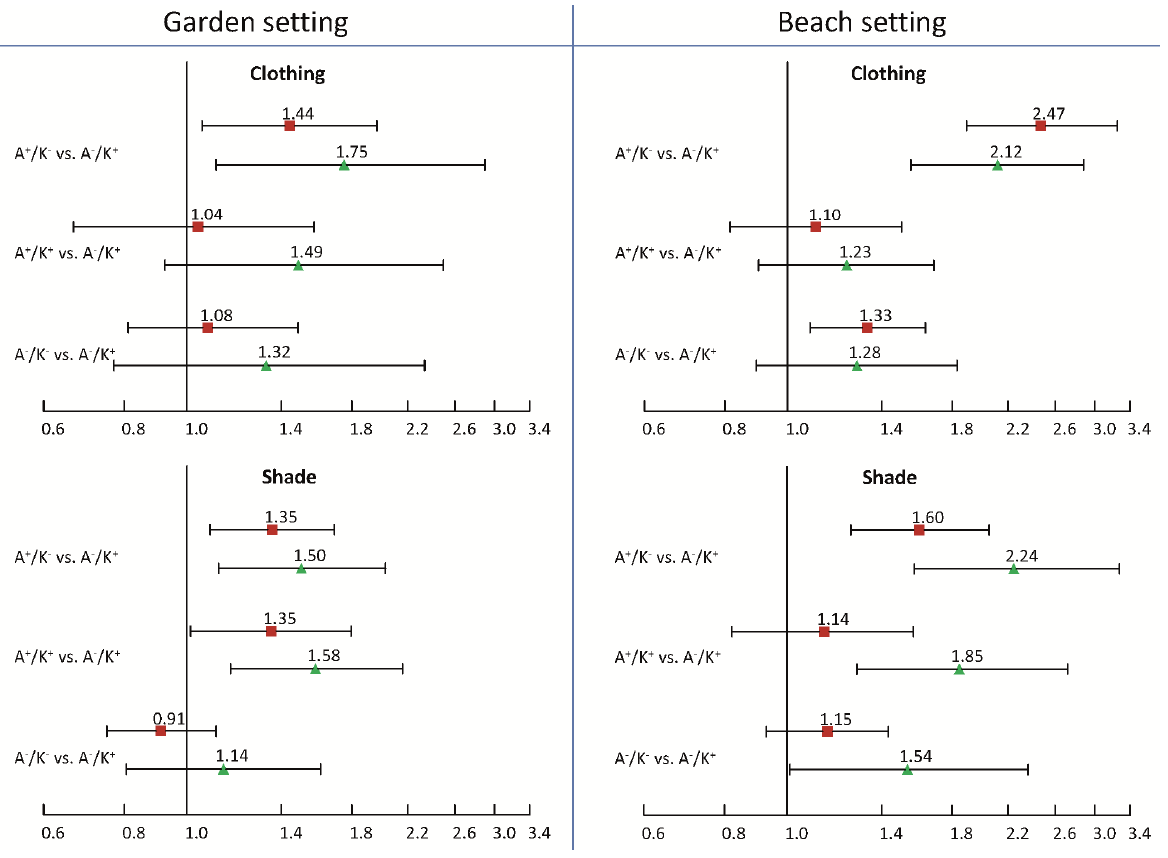
Figure 2. The combined impact of parental knowledge and two (separate) attitudes towards tanning on sun protection practice (four behavioral items) for their